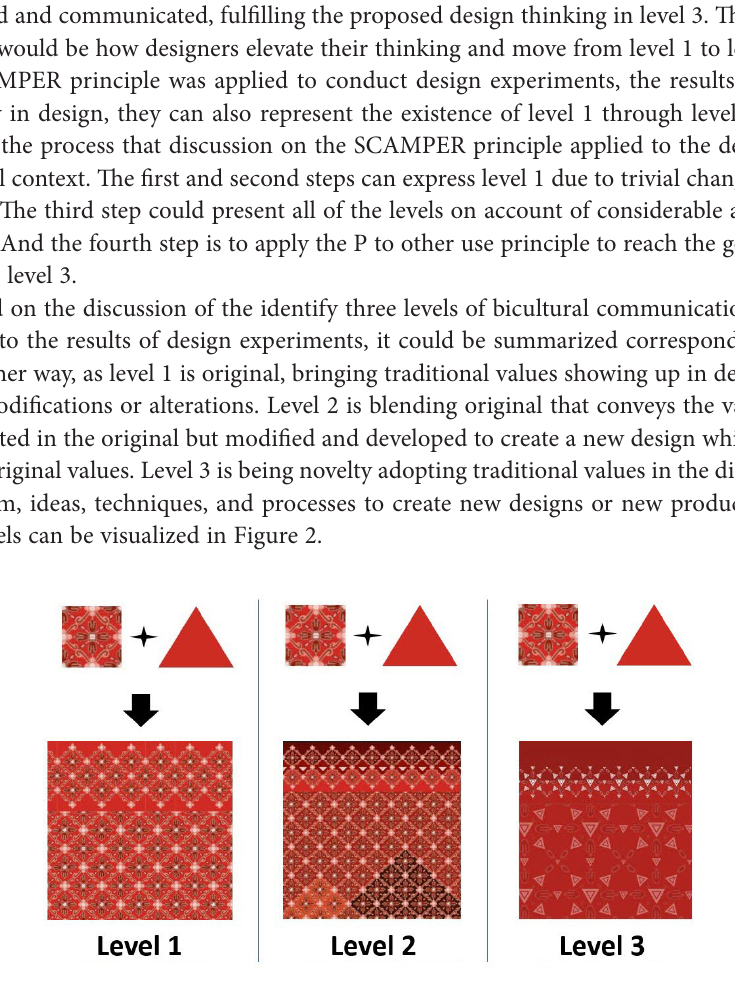
Figure 2. Visualization of levels 1–3 (source: created by